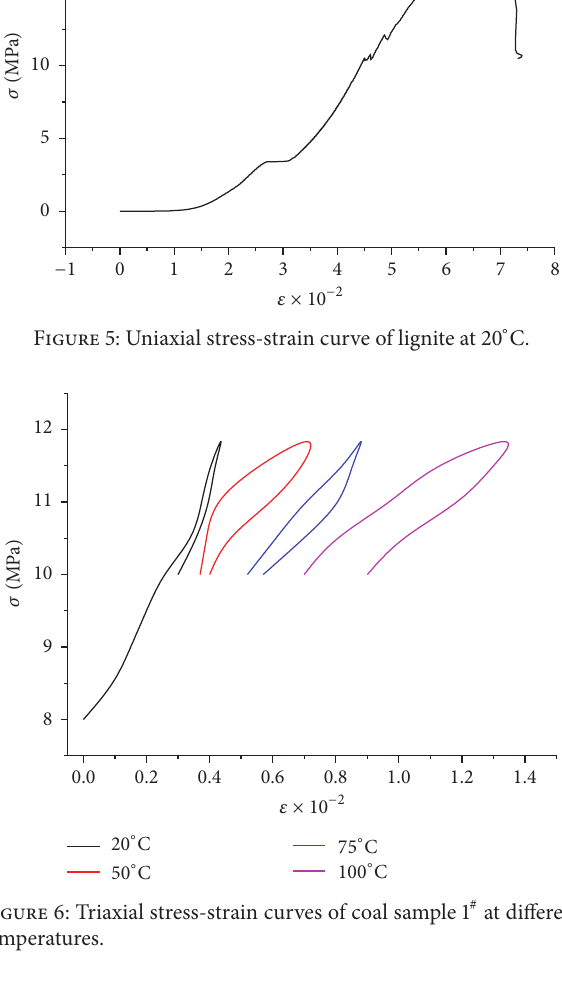
Figure 8: Triaxial stress-strain curves of coal sample 3 # at different